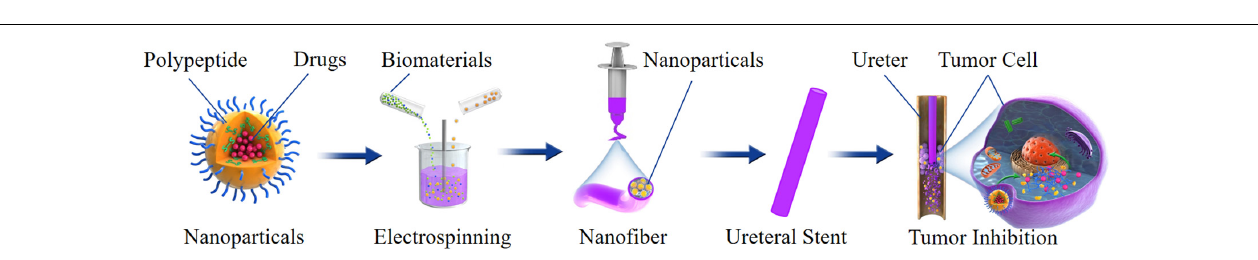
Frontiers in Pharmacology |